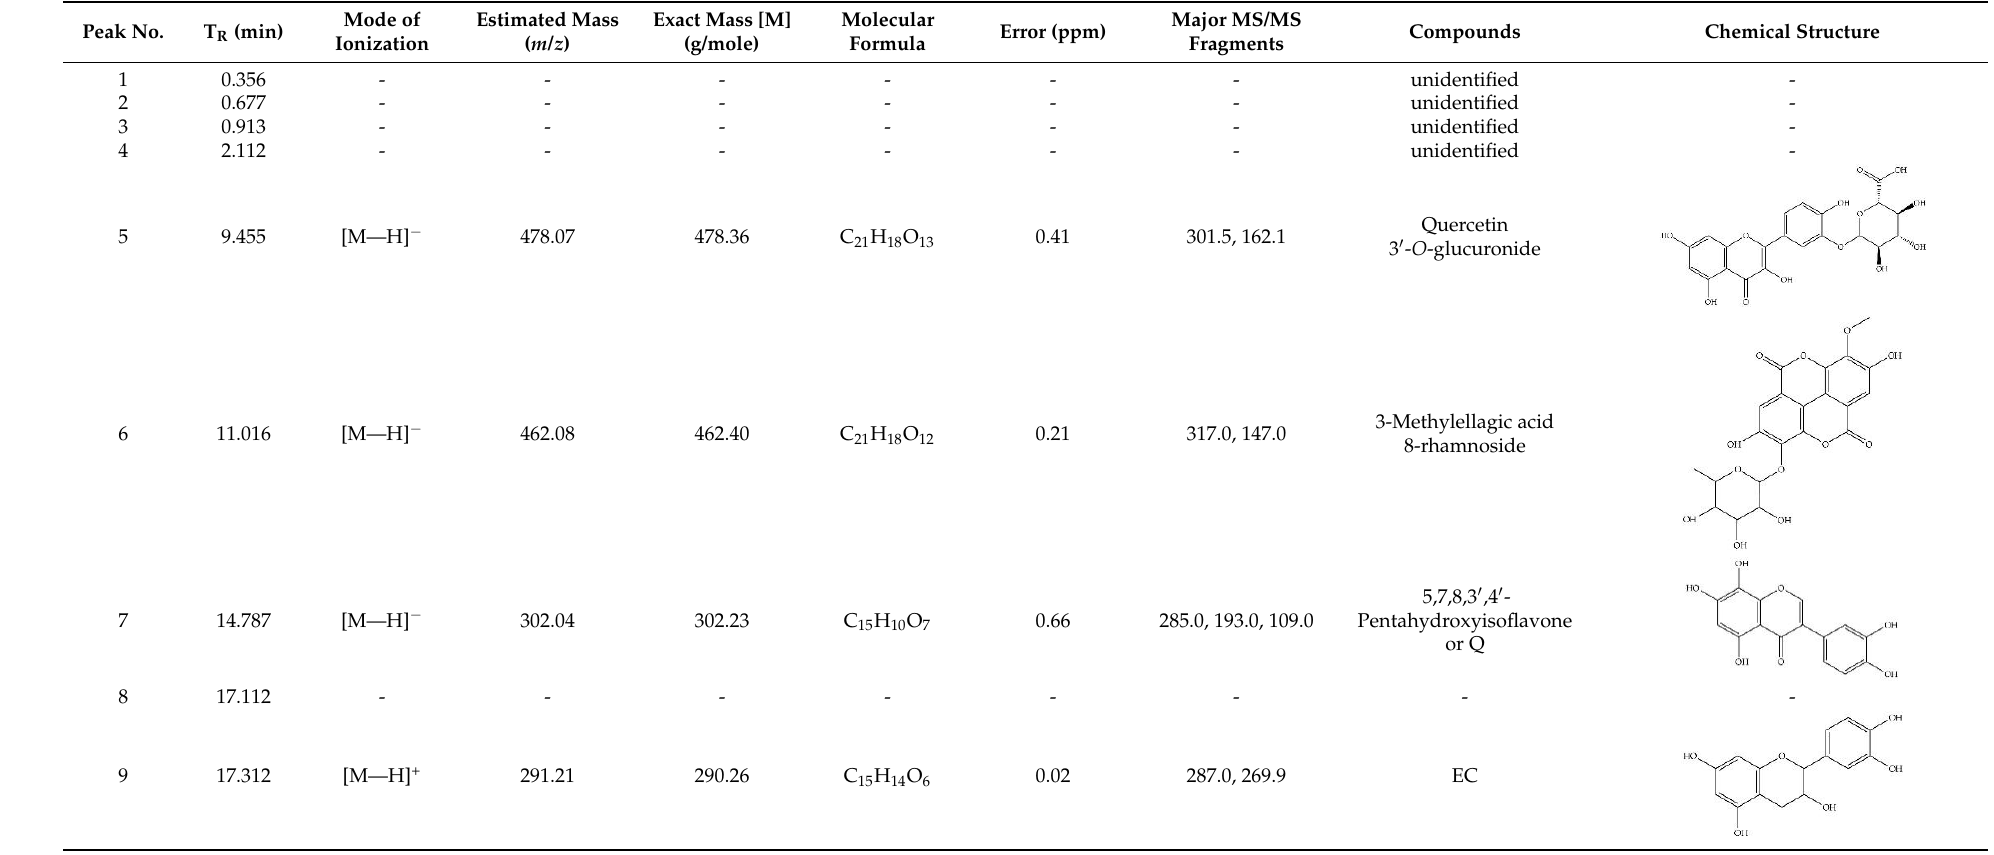
Table 1. UHPLC–ESI-QTOF-MS/MS identification of phenolic compounds in 50% ethanolic extract of P. odoratum Lour. cv. Pakphai leaves. Peak No.